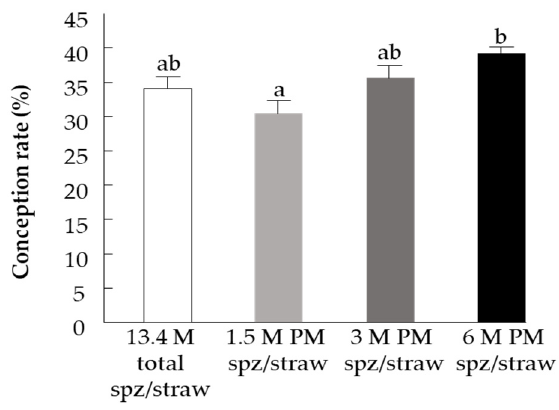
Figure 6. Pregnancy rate following insemination with straws containing 13.4 M spermatozoa (spz) per straw (control) or 1.5 M, 3 M, or 6 M progressively motile spermatozoa (PM spz) per straw. Data are presented as mean ± SEM. Different letters above columns indicate significant differences between groups at p ≤